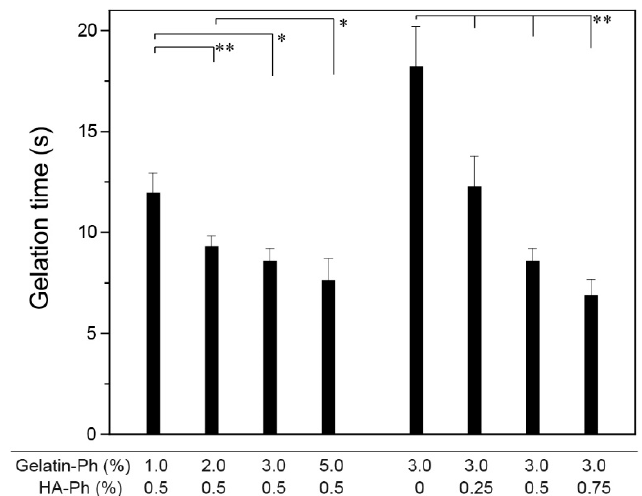
Figure 3. Effects of gelatin-Ph and HA-Ph content on gelation time. Bars: S.D. ( n = 4). * p < 0.05, ** p < 0.01.